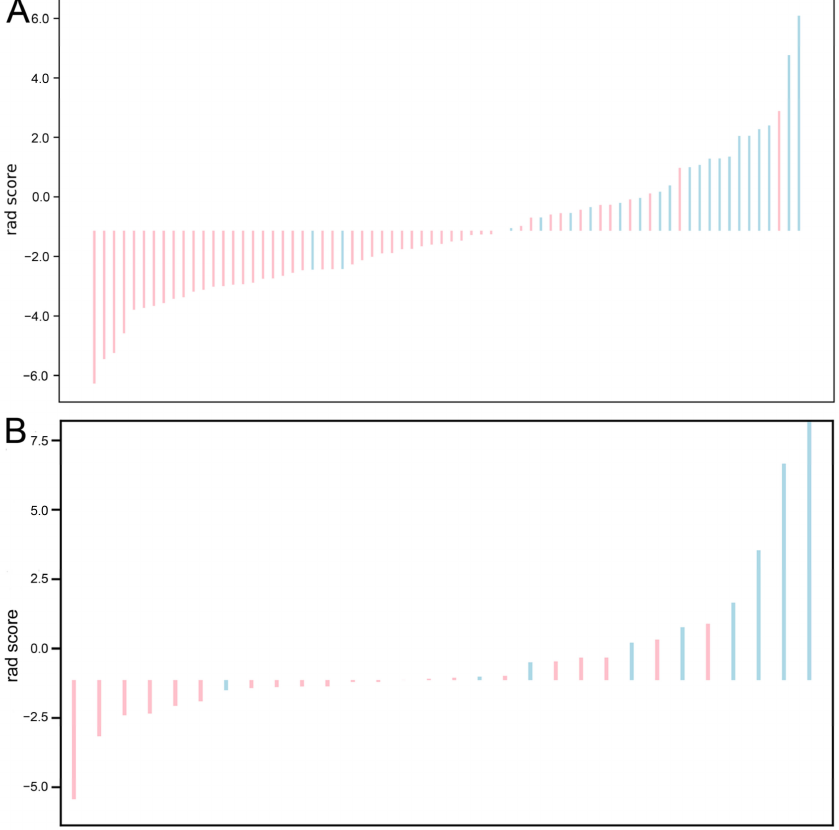
Figure 5. Radiomics score (rad-score) for each tumour in the training cohort ( A ) and validation cohort ( B ). The red bars show the rad-scores of the tumours with significant non-HCC, and the blue bars show the rad-scores of those with significant HCC. HCC, hepatocellular carcinoma.